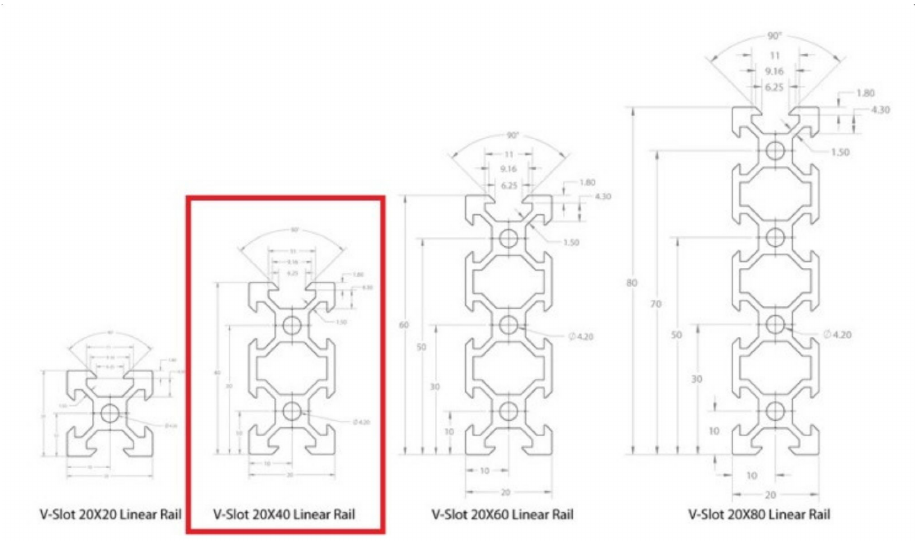
Figure 3. V-Slot aluminum profiles’ types and